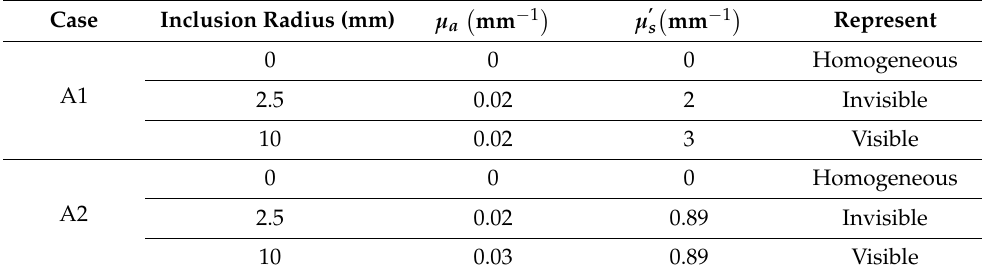
Table 1. Simulation cases with the background µ a = 0.01 mm − 1 and µ (cid:48) s = 1 mm − 1 . Case Inclusion Radius